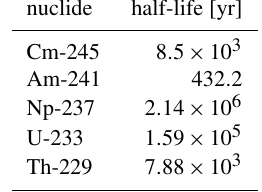
Table 3. The simplified Neptunium chain from Larue et al. (2013). nuclide